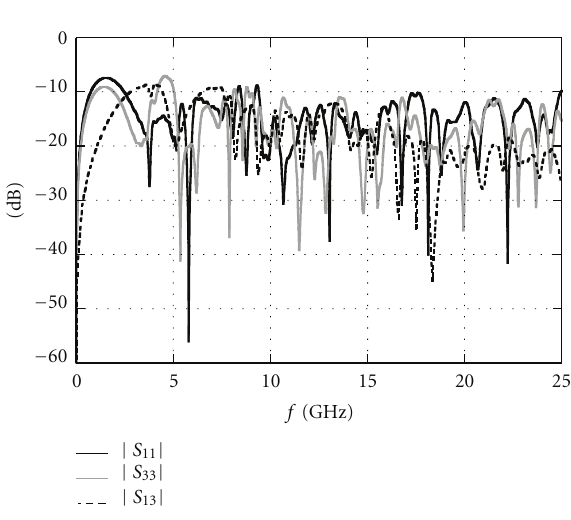
Figure 5: Antenna of Figure 2. Magnitude of the scattering coe ffi cients of the radiating element fed by the four probes. Reflection coe ffi cients | S 11 | at the input port 1 feeding the upper structure ( black line ), | S 33 | at the input port 3 feeding the lower structure ( gray line ), and transmission coe ffi cient | S 31 | from port 1 to port 3 ( dashed black line